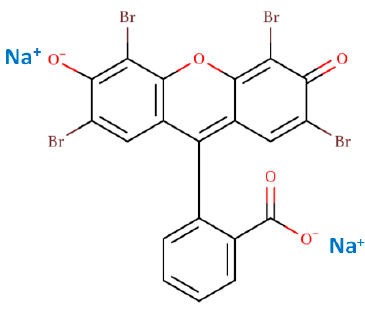
Figure 13. The chemical structure of the used eosin dye.